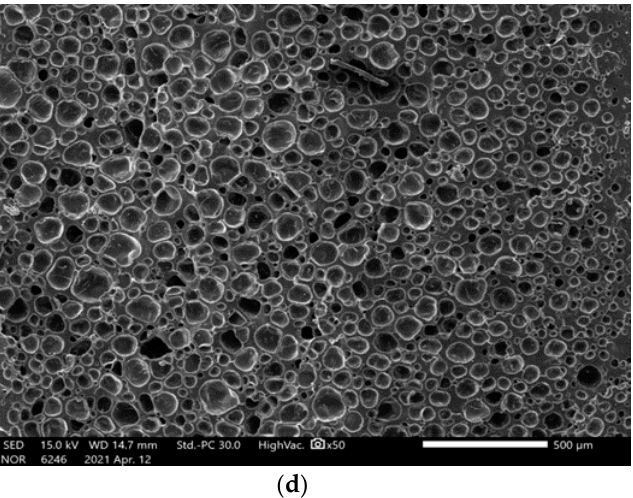
Figure 5. Scanning electron micrograph of ceramic urethane specimens: ( a ) Original (at a magnifi- cation of ×250) ( b ) Microcellular foamed at a temperature of 150 °C (at a magnification of ×250) ( c ) Microcellular foamed at a temperature of 130 °C (at a magnification of ×50); ( d ) Microcellular foamed at a temperature of 150 °C (at a magnification of ×50).